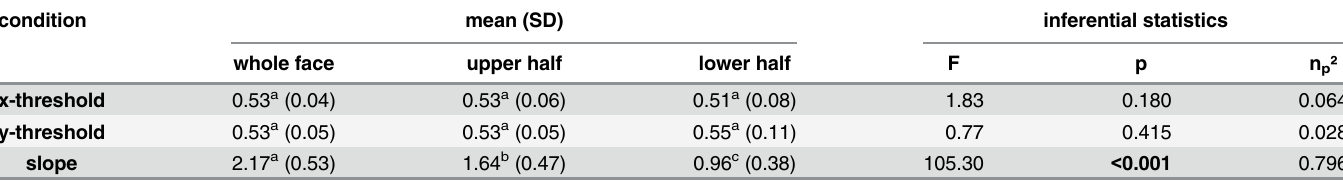
Results of a repeated measures ANOVA for the different curve parameters; means in the same row sharing the same superscript letter do not differ signi fi cantly from one another at α = 0.05; degrees of freedom (df) for x-threshold: 1.5,41.6 (Greenhouse-Geisser corrected); df for y-threshold: 1.3, 33.9 (Greenhouse-Geisser corrected); df for slope: